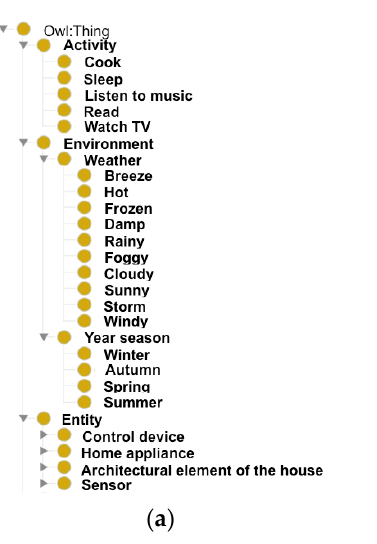
Figure 3. Domotic ontology: (a) Fragment 1, (b) Fragment 2.